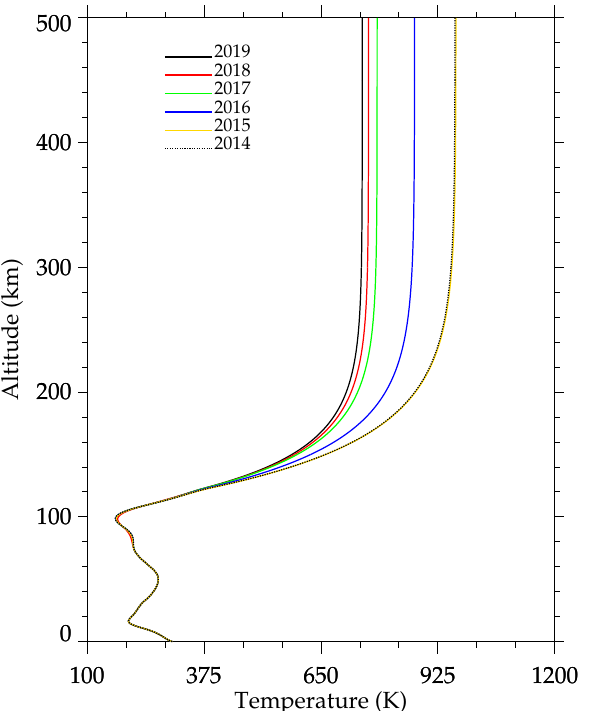
Figure 12. Thermospheric neutral temperature profiles from 2014 to 2019 by the NRLMSIS-00 model